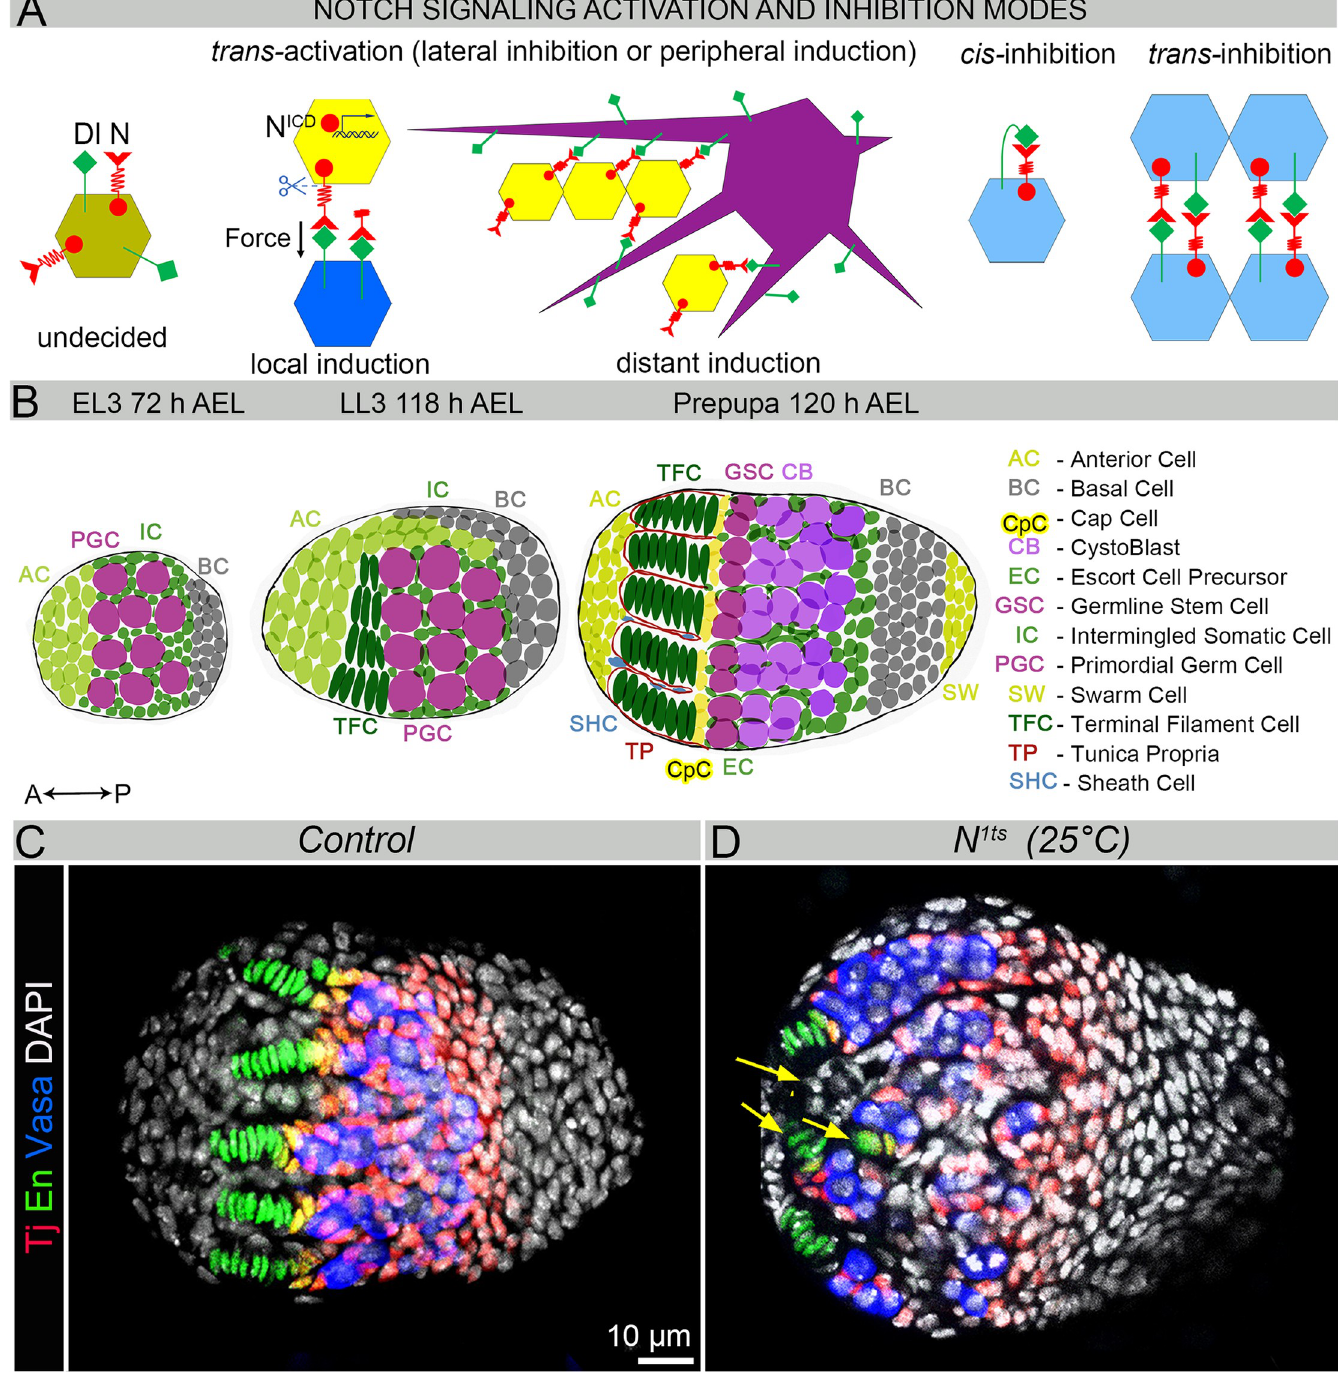
Fig 1. Ovarian morphogenesis is defective in Notch signaling mutants. ( A ) Models of Notch signaling activation and inhibition modes. During development, cells can express both Delta and Notch and be “undecided” with regards to the Notch signaling status (olive cell). However, typically, Notch signaling is actively induced via trans- interaction: a cell that expresses activated Delta ligand induces Notch signaling in the neighboring cells and represses their choice to become Delta-sending cells. This signaling is called “lateral inhibition” if among equipotent cells or “peripheral induction” if among non-equipotent cell populations. Peripheral induction can be divided into two different types: 1) local induction, when Notch signaling is activated in the cells whose membranes which are in direct contact with those of the Delta- expressing cell; and 2) distant induction, when Notch signaling is activated in the cells that are localized several cell diameters away with the help of cellular Delta- sending projections. As a result of the Notch-inductive mode, direct activation of the genes coding for factors establishing terminally differentiated cell fates is induced. In some cases, Notch signaling can be inhibited by the intrinsic or extrinsic interaction of the Delta ligand and the Notch receptor ( cis- or trans- inhibition). Expressed in